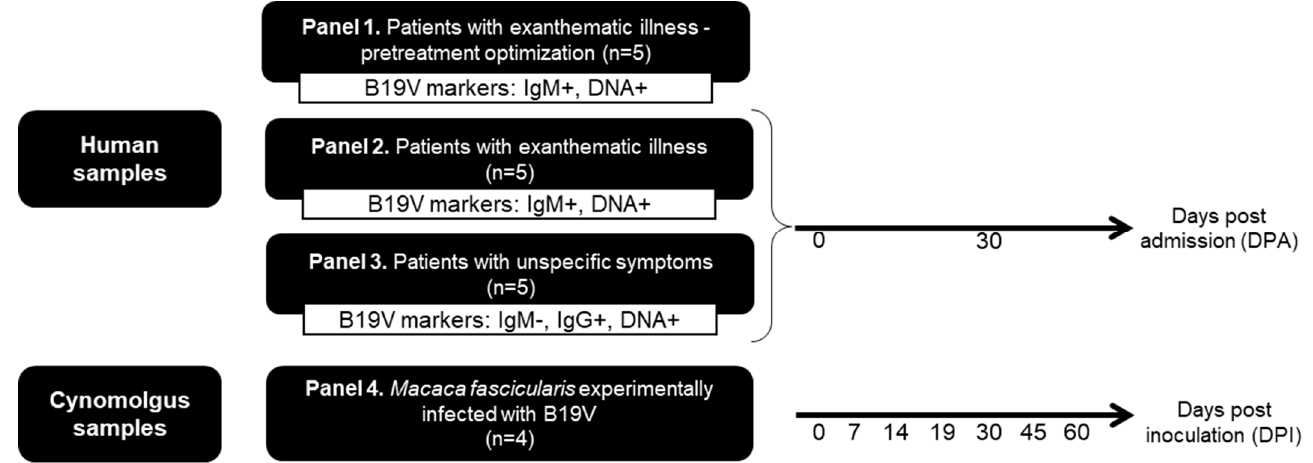
Figure 1. Study population. Serum samples were obtained from patients with B19V markers (IgM, IgG and DNA). Serum and bone marrow (BM) samples were obtained from cynomolgus monkeys experimentally infected with B19V.